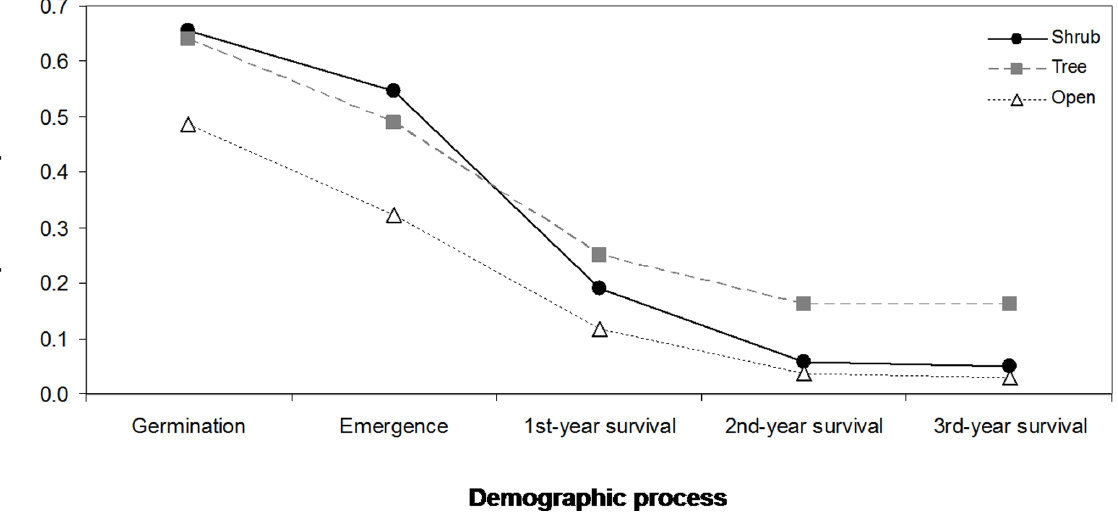
Figure 4. Cumulative probability of transition from seed germination to 3 rd -year seedling survival in the three microhabitat types. Values of probability were averaged for the two oak species ( Q. suber and Q. canariensis ). Microhabitat suitability for each of the demographic processes was assessed by using wire cages with a small mesh size to exclude all potential acorn consumers.